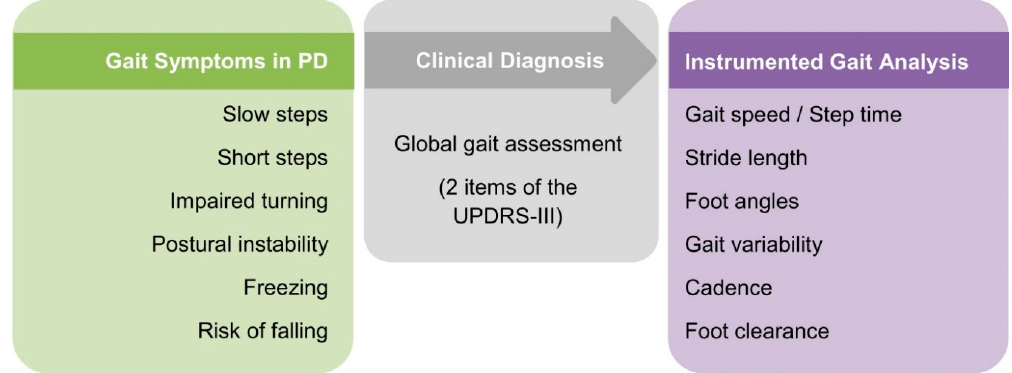
Figure 7. Clinical diagnosis based on the Unified Parkinson Disease Rating Scale, part III motor score (UPDRS-III) is not able to adequately reflect all gait impairments that occur in Parkinson’s disease (PD). An instrumented gait analysis complements clinical assessment by providing different objective parameters evaluating the broad spectrum of gait disturbances in PD.